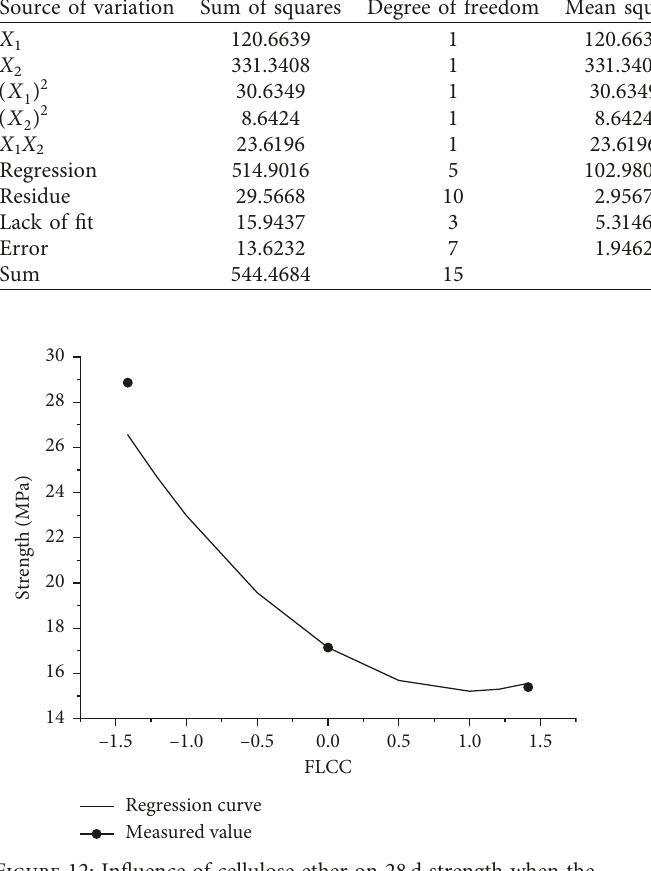
Figure 12: Influence of cellulose ether on 28d strength when the substitution rate of rubber is 0.